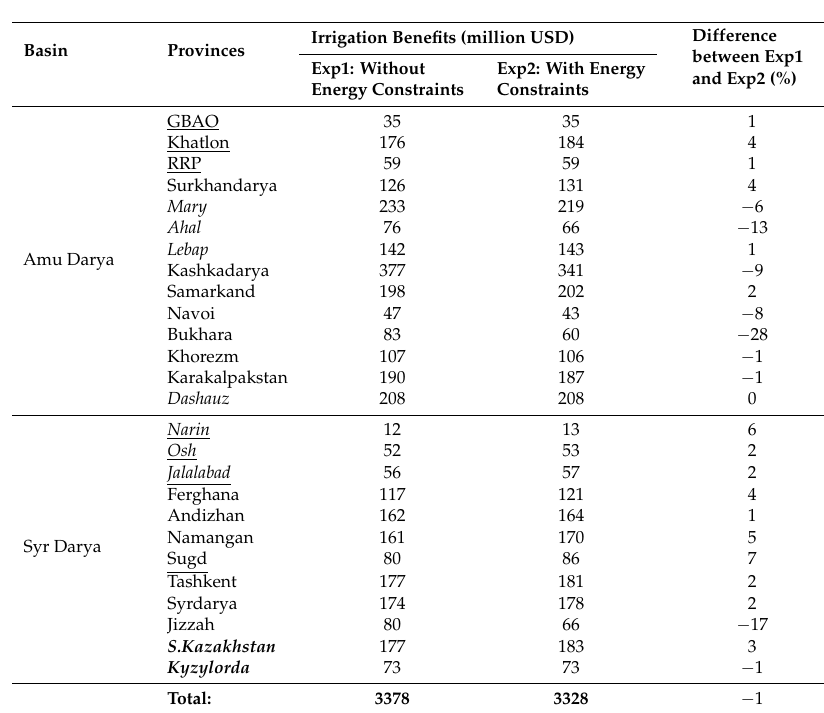
Table 3. Optimal levels of irrigation benefits without (Experiment 1) and with (Experiment 2) considering the energy production and consumption sub-module. Provinces underlined are in Tajikistan, those underlined and in italics are in Kyrgyzstan, those in italics are in Turkmenistan, those in italics and bold are in Kazakhstan, and those in a normal typeface (i.e., not underlined, in italics, or bold) are in Uzbekistan.